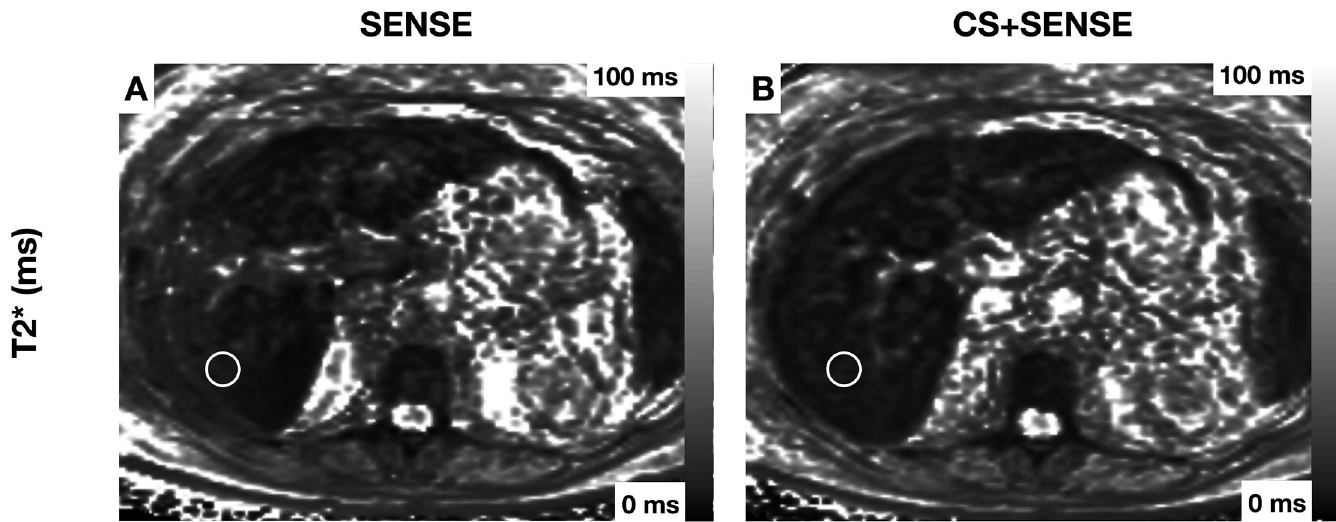
Fig 4. Patient with hemosiderosis and severe reduction of T2 � Exemplary region of interest is drawn in segment VII (1.5cm). T2 � : acquisition with SENSE 4.03 ± 0.8ms (A); acquisition with CS+SENSE 5.56 ± 1.0ms (B).